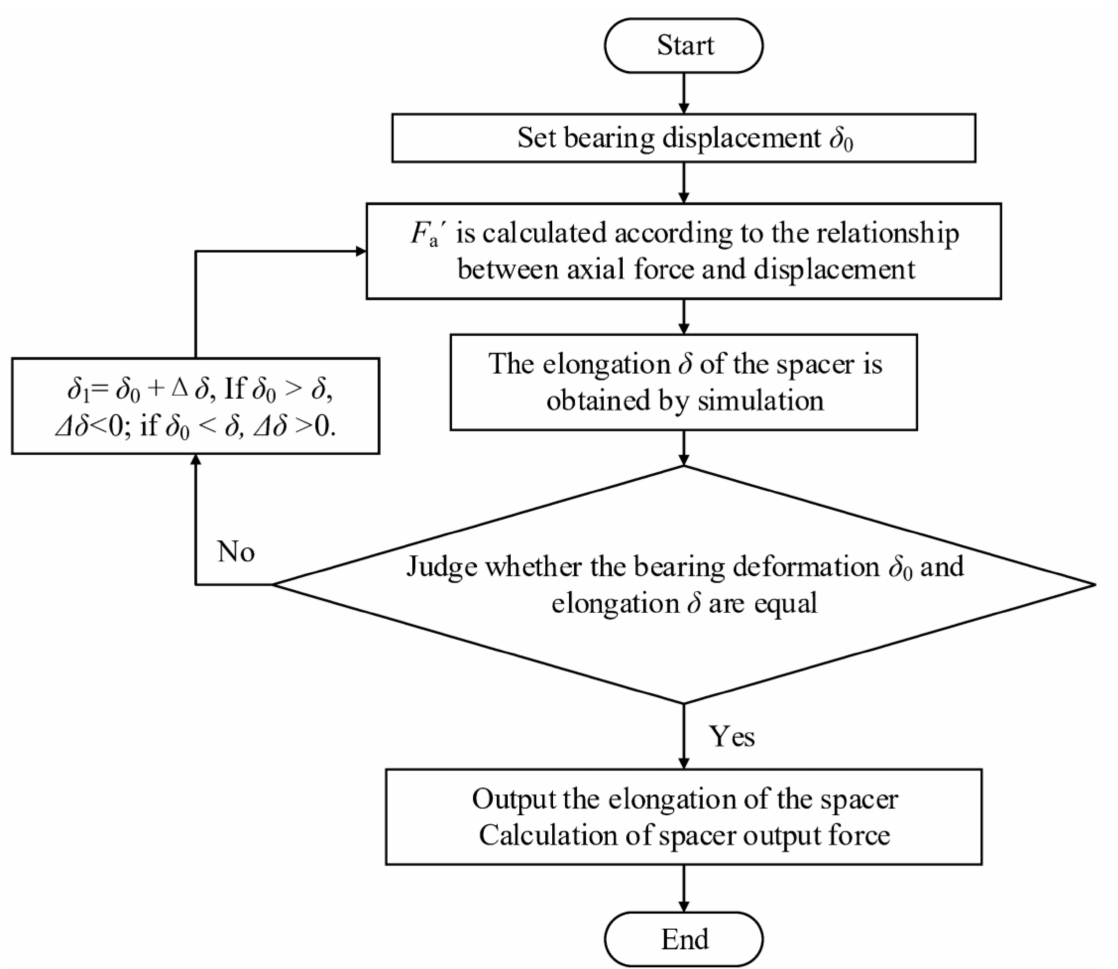
Figure 7. Flowchart of output force